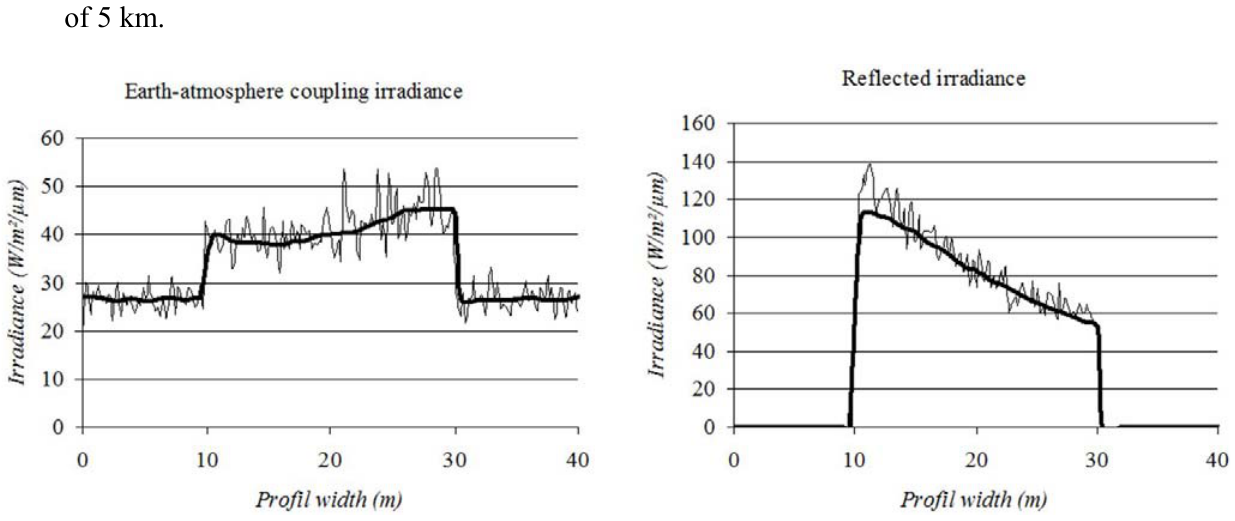
Figure 6. Comparison of simulation results obtained with AMARTIS v1 (thin line) and AMARTIS v2 (thick line) in the street case No. 1 ( cf. Figure 4) at 440 nm with a visibility of 5